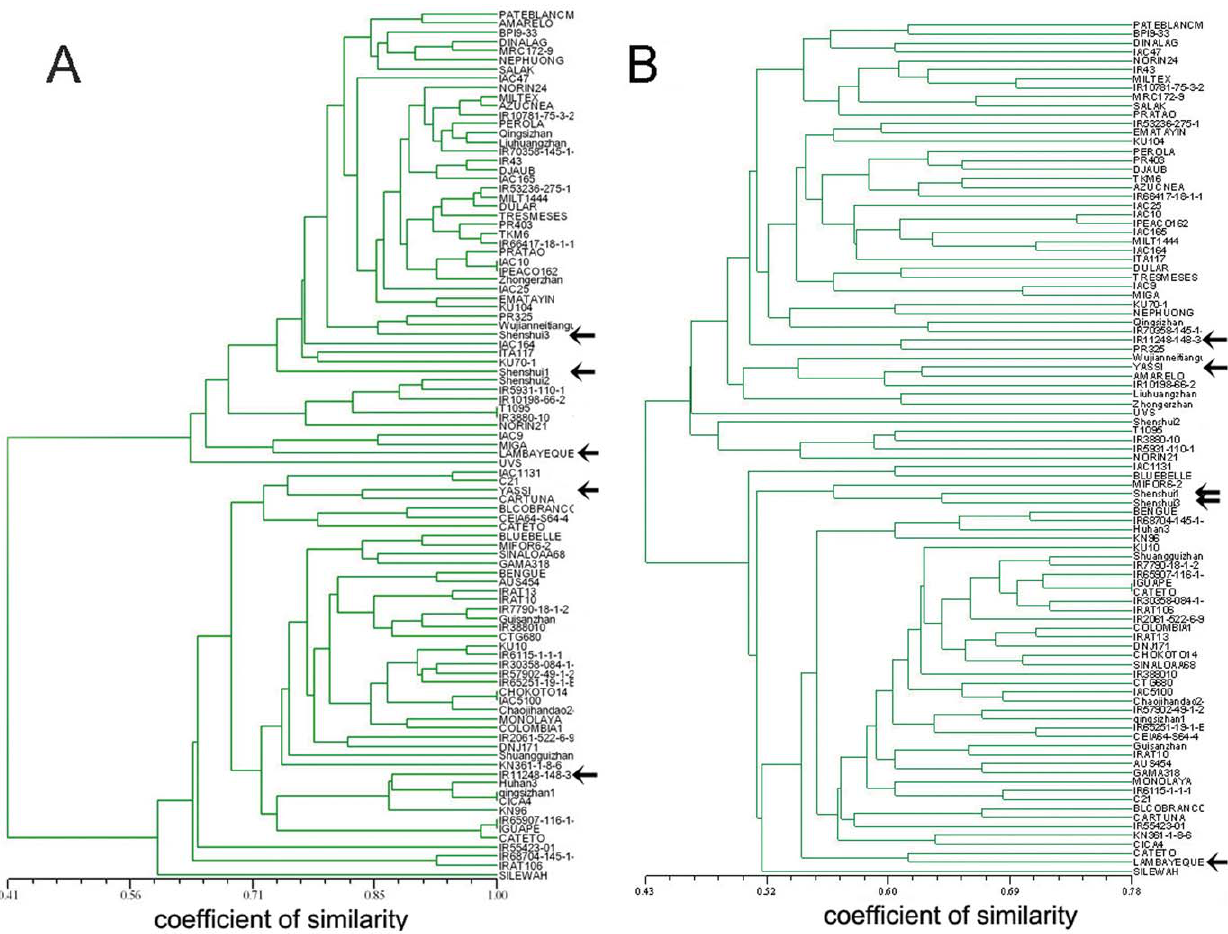
Figure 2. UPGMA clustering of 95 rice accessions. A, clustering based on TILLING markers of promoters; B, clustering based on InDel loci. The arrows indicate the accessions being clustered into opposite sub-populations between two trees. The horizontal axis represents the coefficient of similarity. doi:10.1371/journal.pone.0030765.g002 Table 3. The results of associated analysis between transcription factor promoters and DT traits during drought treatment.